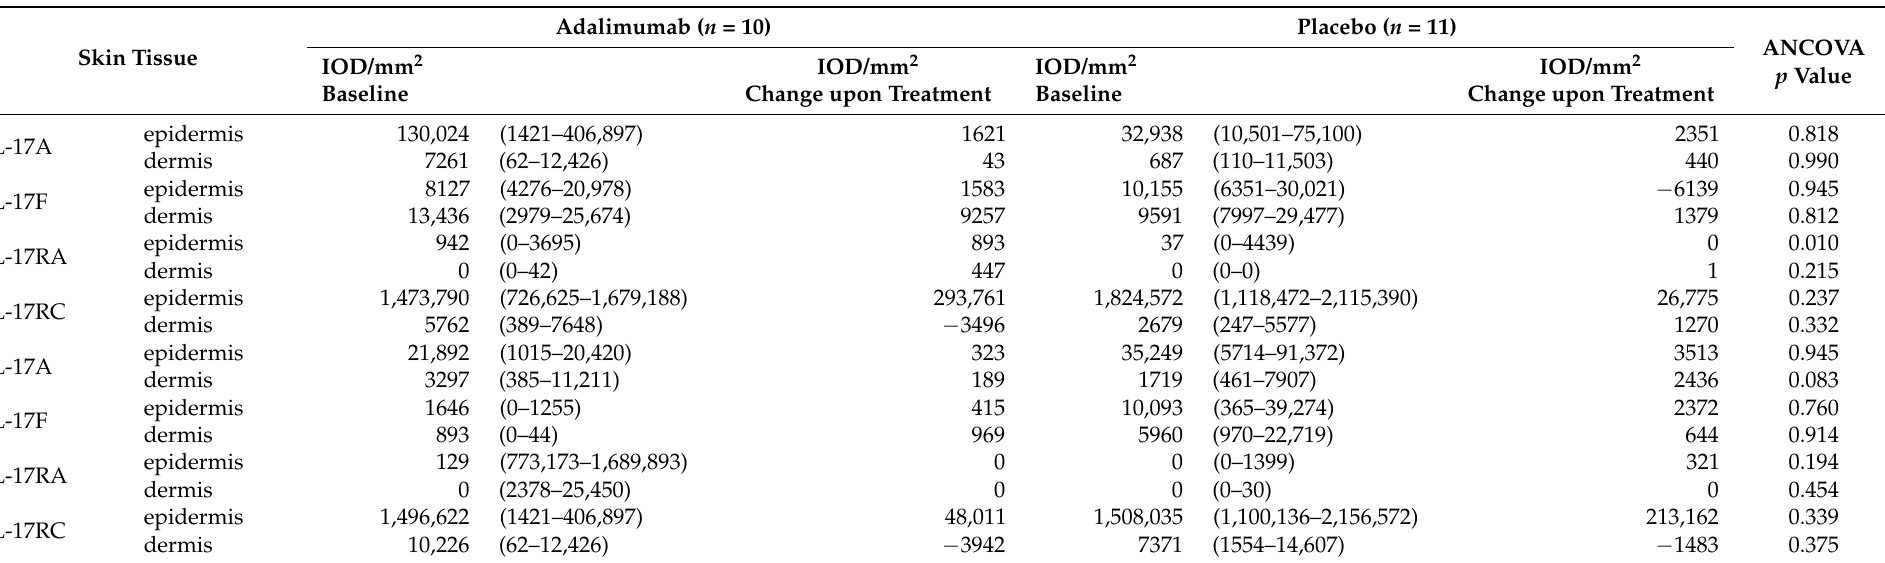
Table 2. Median IOD/mm 2 values of IL-17 expression in lesional and nonlesional skin before and after treatment with adalimumab compared to